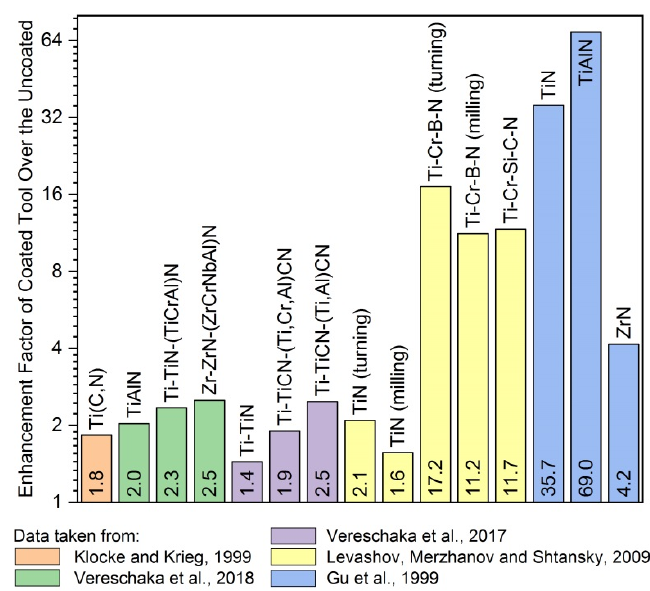
Figure 7. Comparison of enhancement factors of coated tools over uncoated tools (based on their lifetime). Analysed data are taken from selected published works [95–99]. The results strongly depend on operational conditions, such as the cutting method and speed, the workpiece material, and the thickness of the protective coating.